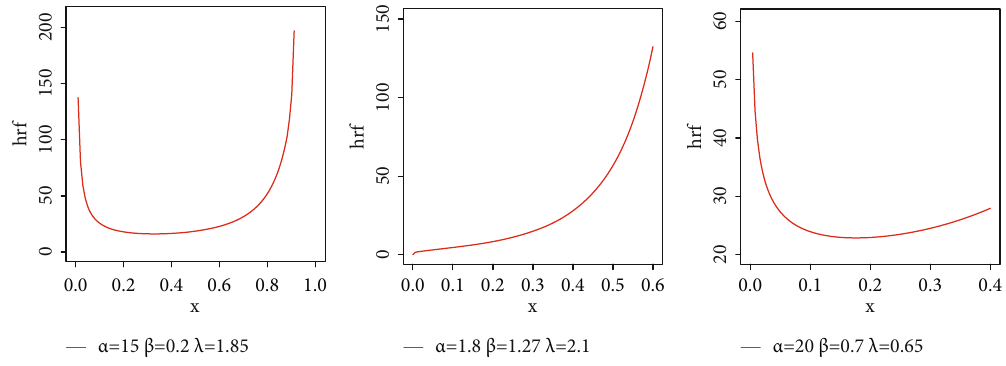
Figure 3: Plots of UPWD hrf for some parametric